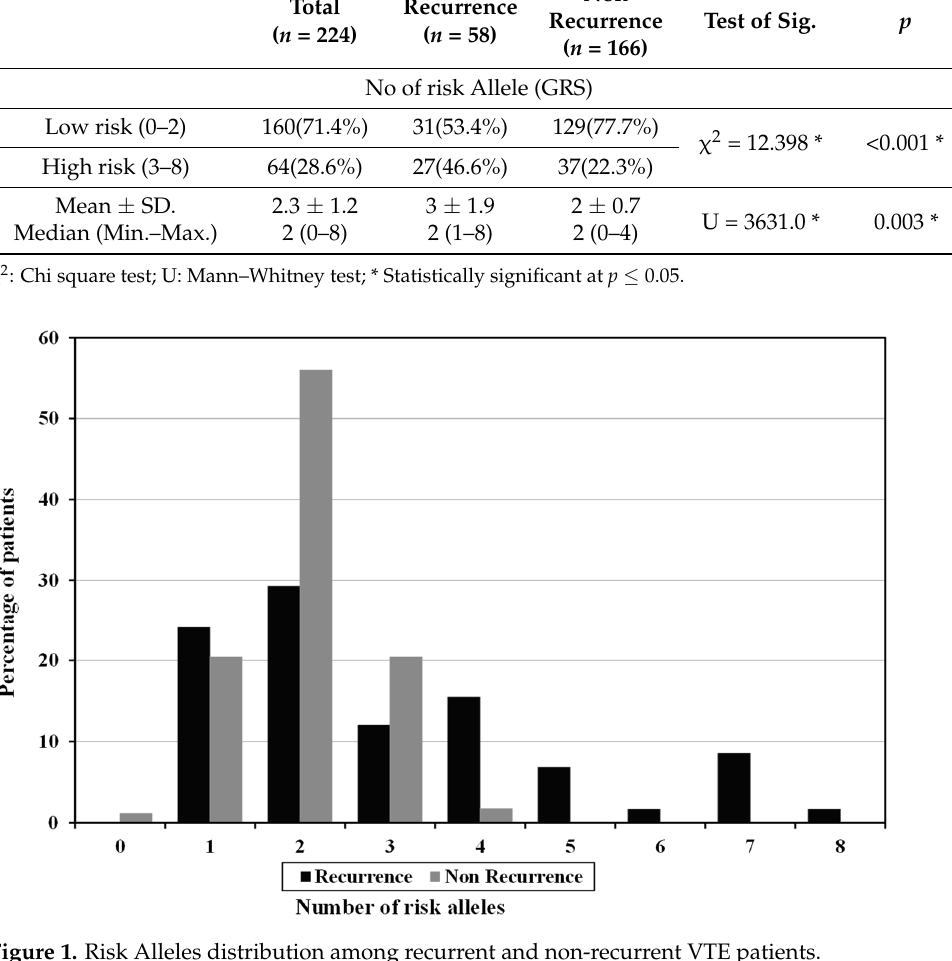
Figure 1. Risk Alleles distribution among recurrent and non-recurrent VTE patients. Table 5. The Risk of Recurrent VTE Associated With the five SNPs among the two studied groups of patients.